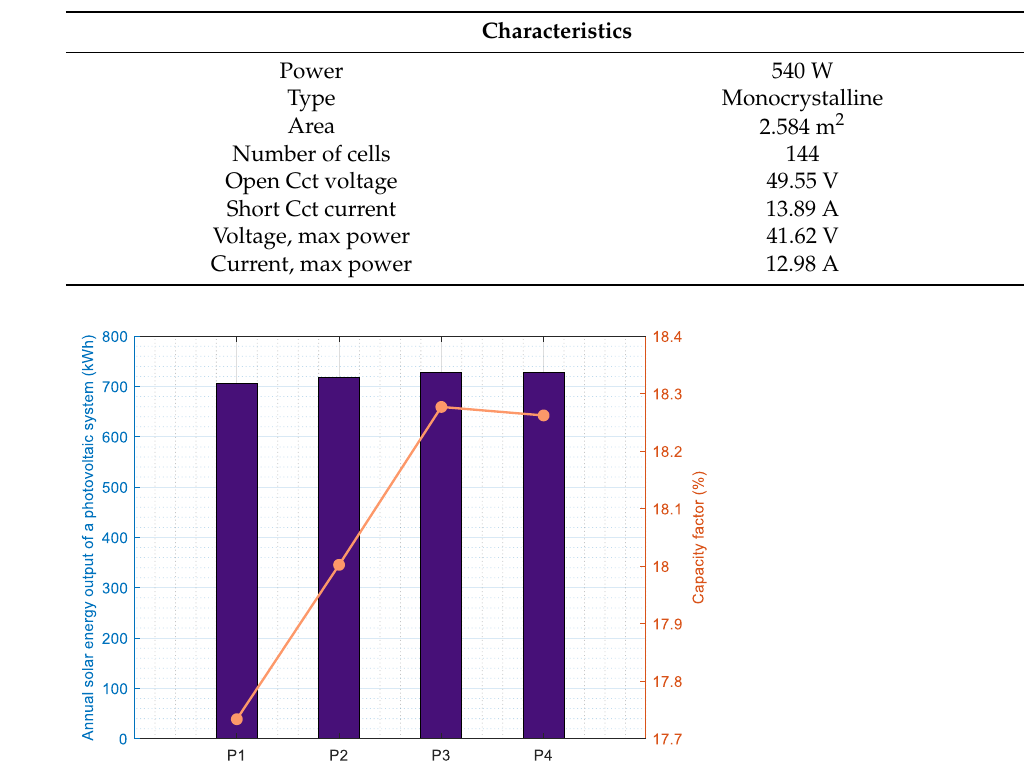
Figure 6. The annual variation in declination angle. Table 3. PV catalog specifications.